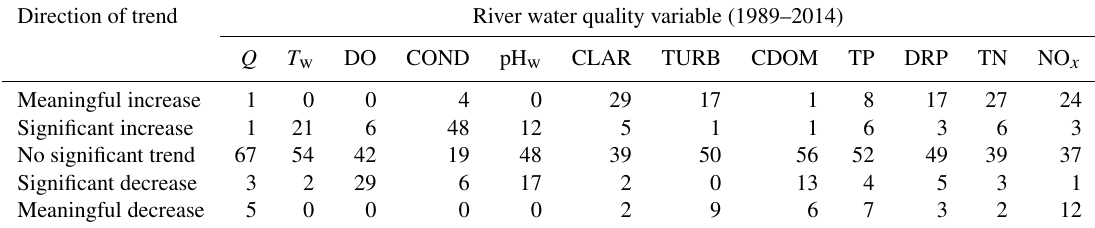
Table 6. River water quality trends from 1989 to 2014. The table reports numbers of sites (out of 77) in different categories of water quality time trend. All variables were flow-adjusted except flow and water temperature. Significant trends were taken to be those with a p value<0.05 in the seasonal Kendall test. Meaningful trends were taken to be those that also had a magnitude (RSKSE) greater than 1% per year. Direction of